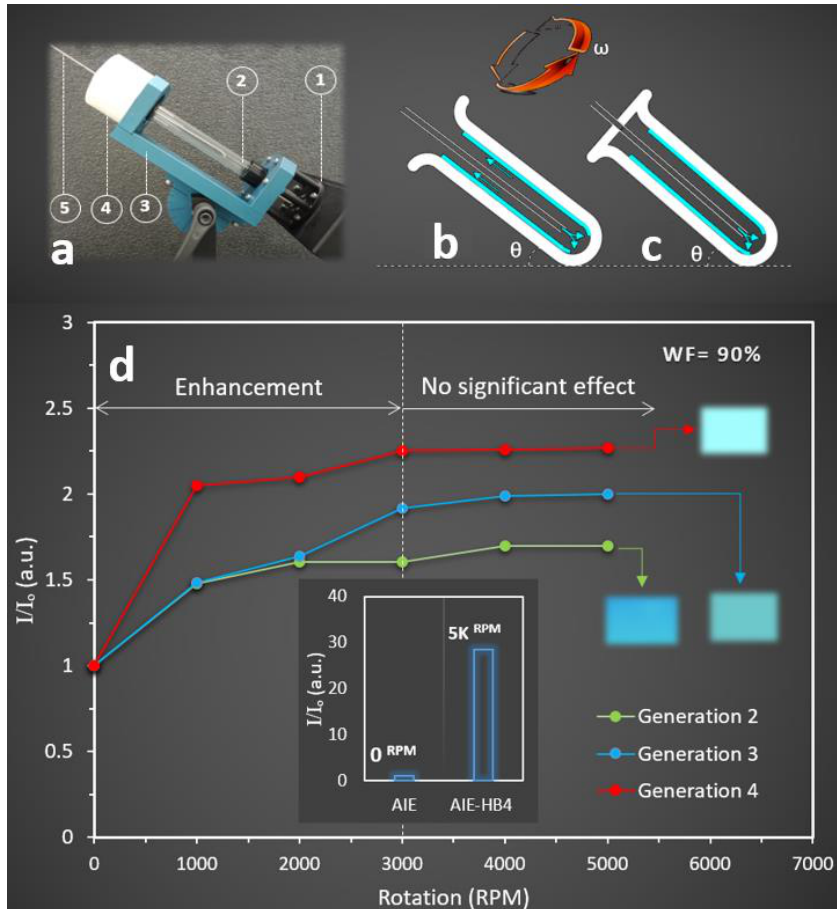
Figure 2. ( a ) Camera image of a VFD indicating its compartments: 1—electrical motor, 2—quartz tube, 3—base, 4—sample collector, and 5—jet feed inlet. Schematic drawing of a VFD tube representing ( b ) continuous flow and ( c ) confined modes with θ and ω representing the tilt angle and